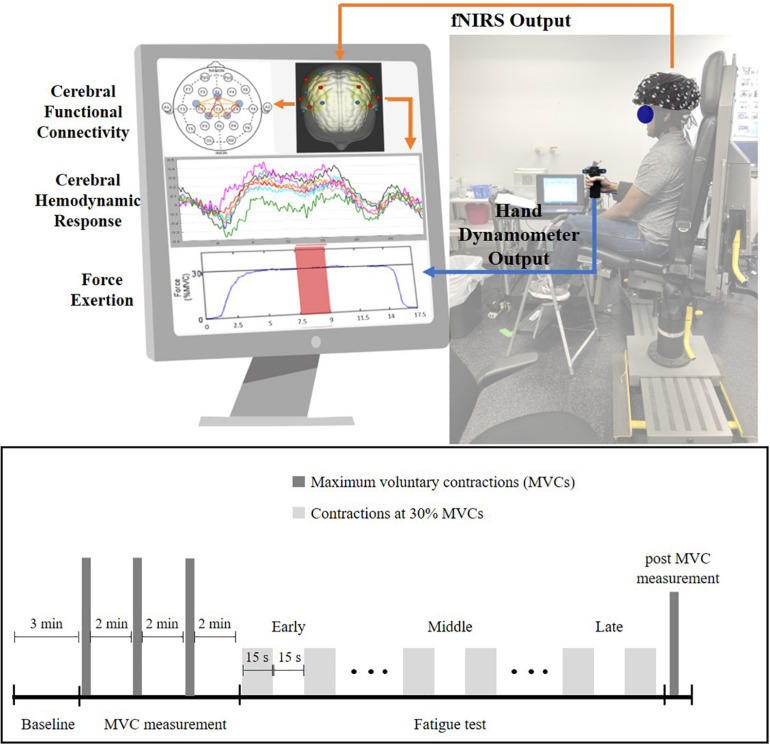
Experiment setup (top) and experiment protocol (bottom) for the handgrip fatigue experiment. Early phase is the first one-third of the 30% MVC period, Middle phase is middle one-third and Late phase is last-one third of the 30% MVC period. Force data and fNIRS data were recorded throughout the experiment. Participant had real-time feedback of their handgrip performance through a display monitor.